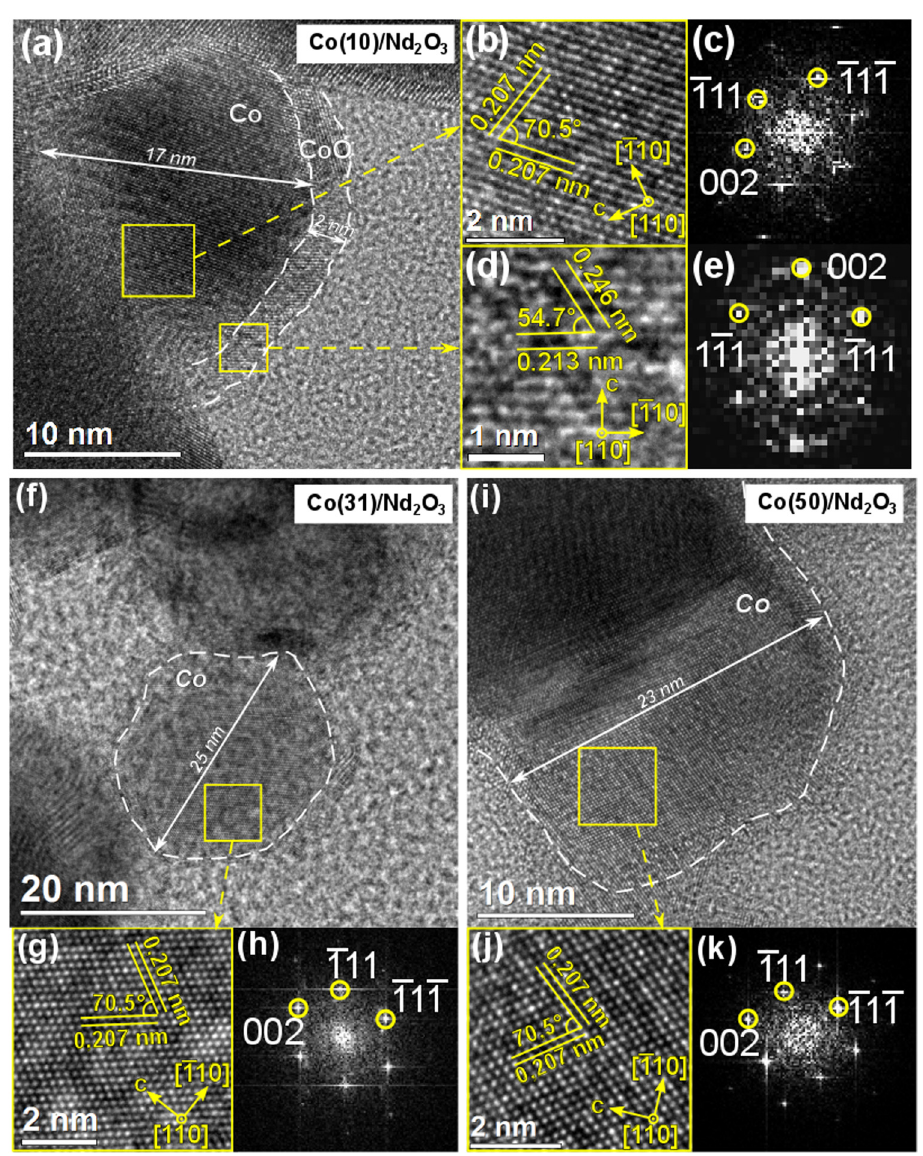
Figure 5. HRTEM images of exemplary Co crystallites ( a , f , i ) and magnified images of highlighted regions of the Co crystallites ( b , g , j ) and CoO layer ( c ) with corresponding Fourier transform (FT) ( d , e , h , k ). Yellow circles mark the reflections on the FT generated by the indicated crystal planes.